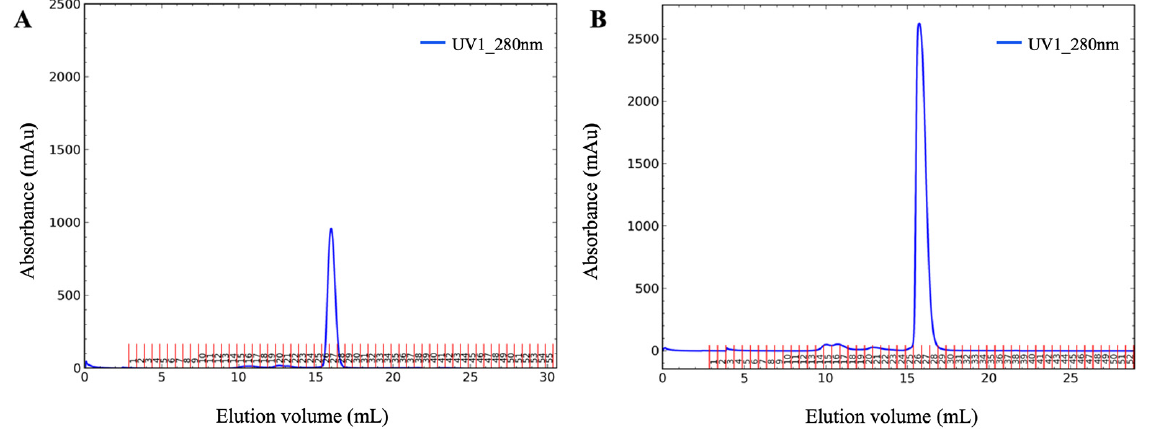
Figure 3. Size-exclusion chromatograms as the last purification step of the expression of the Nb20 nanobody from the ( A ) C43(DE3) bacterial strain periplasmic fraction and ( B ) Shuffle-T7 bacterial strain from the cytoplasmic fraction. By comparing the size-exclusion chromatography results, the expression yield was much higher when the Shuffle-T7 strain was used, which was expected. The amount of the starting bacterial pellet, after expression in one liter of nutrition solution, was the same in each case.